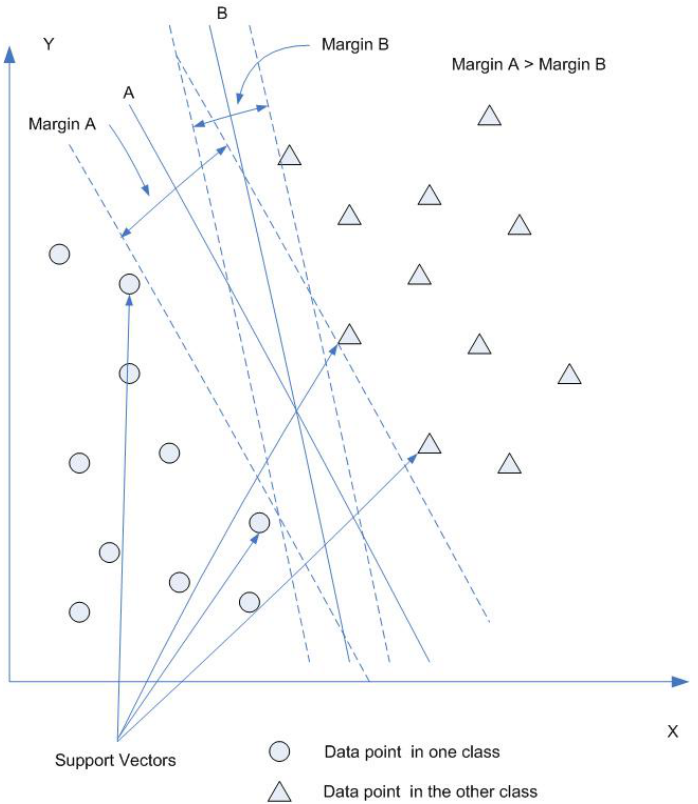
Figure 9. Margin between support vectors in